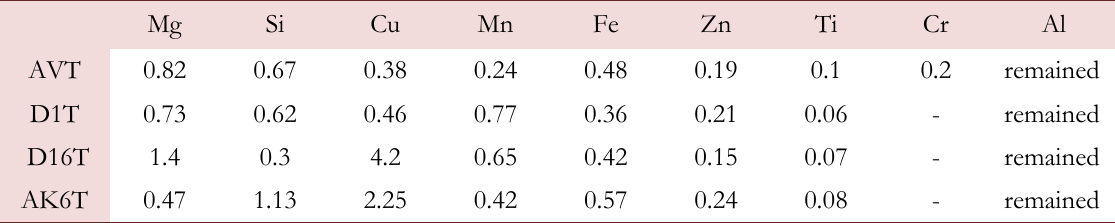
Table 1: The composition (in %) of investigated